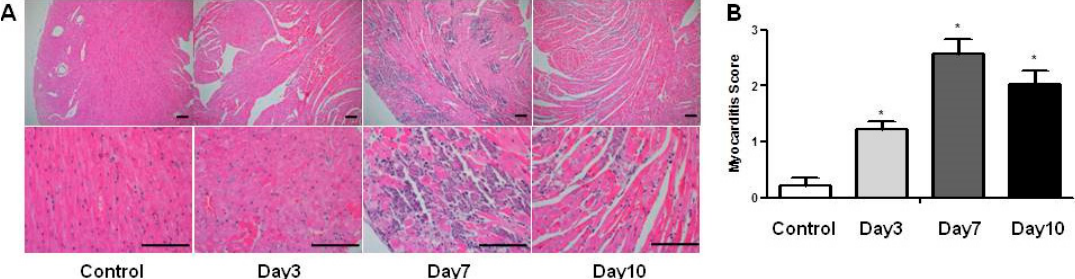
Figure 2. Histopathologic findings of the hearts over time in mice with acute viral myocarditis. ( A ) Changes in histology of heart over time after CVB3 infection (hematoxylin and eosin stain). Scale bar of panel, 100 µm; ( B ) Semiquantitative analysis by the degree of myocardial inflammation. Infiltration of inflammatory cells, myocardial necrosis, fibrosis and mineralization was shown at day 7 after the CVB3 infection. In B, data are presented as mean ± SEM and analyzed by one-way ANOVA, post hoc Dunnett test ( n = 5 in control; n = 10 in day 3; n = 10 in day 7; n = 7 in day 10). * p < 0.05 vs. control group.